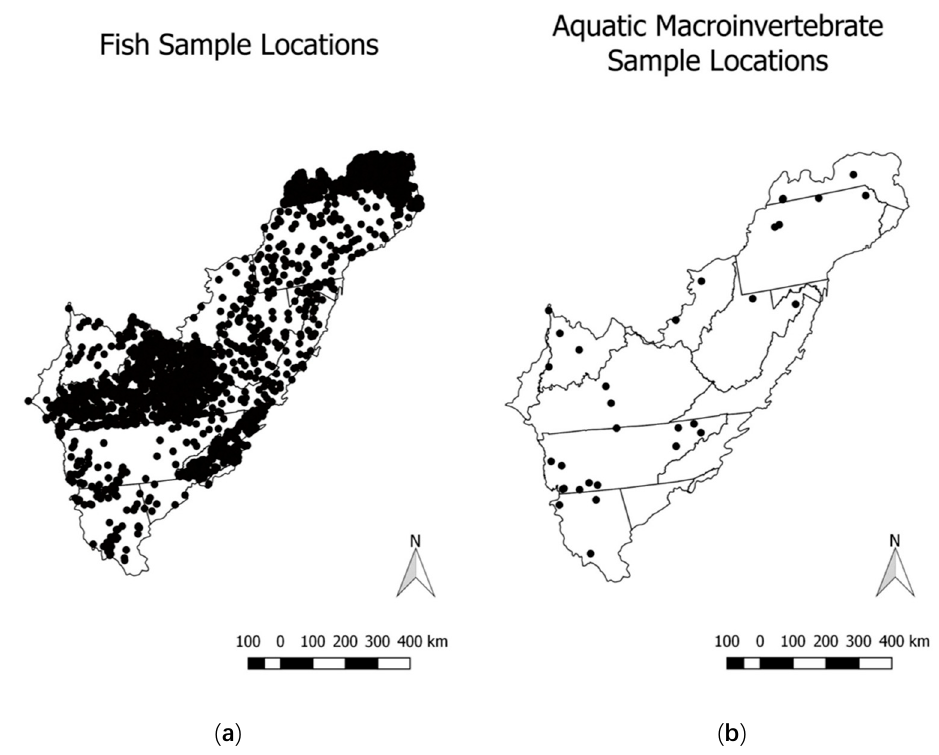
Figure 2. Side-by-side comparison of response data for ( a ) fish and ( b ) aquatic macroinvertebrates showing spatial distribution of sample locations for both. Data source: United States Environmental Protection Agency’s National Rivers and Streams Assessment and the National Fish Habitat Partnership. Map created by R. Daniel Hanks using ArcGIS v10.3 [22].